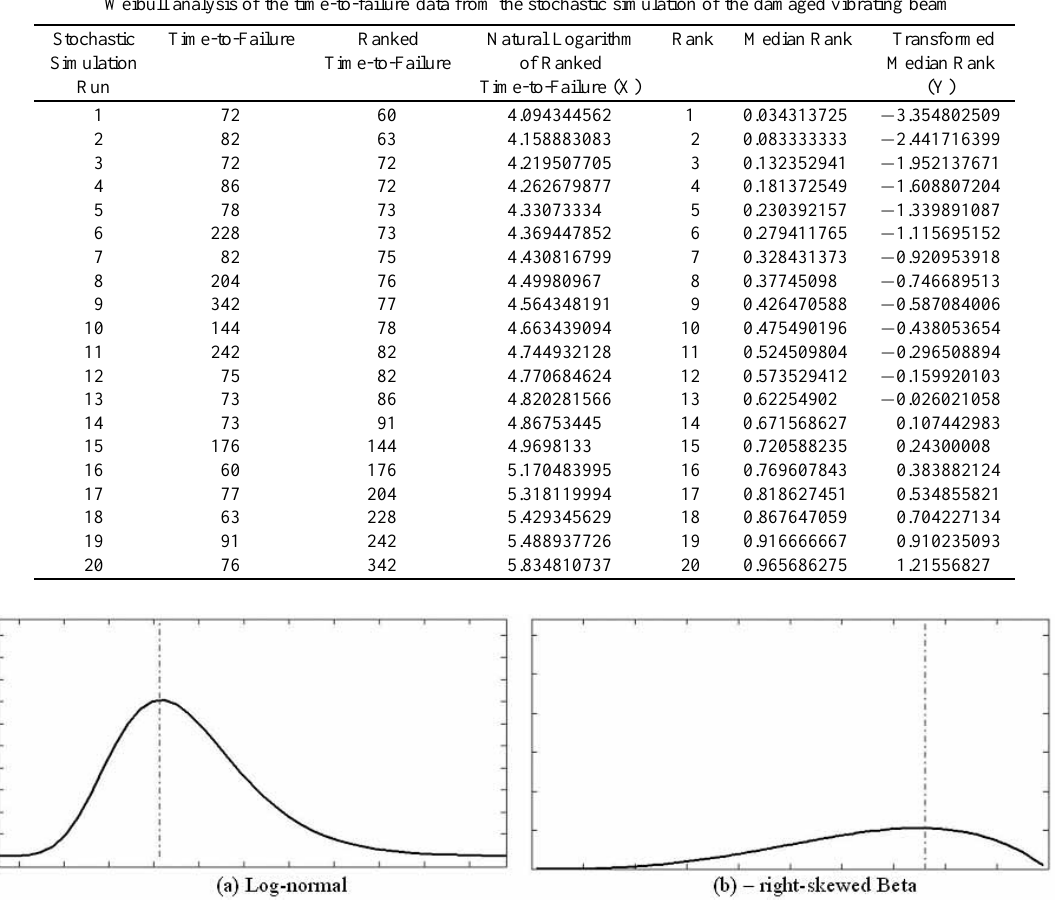
Fig. 9. Shapes of the probability density functions assumed for material properties (a) and loads (b) variations. The observed times-to-failure are ranked in ascending order from 1 to n ( n = 20, the number of runs within the stochastic simulation). For each of the ranks, the median ranks (MeR) are calculated and then transformed (TMeR), according to Eqs (16) and